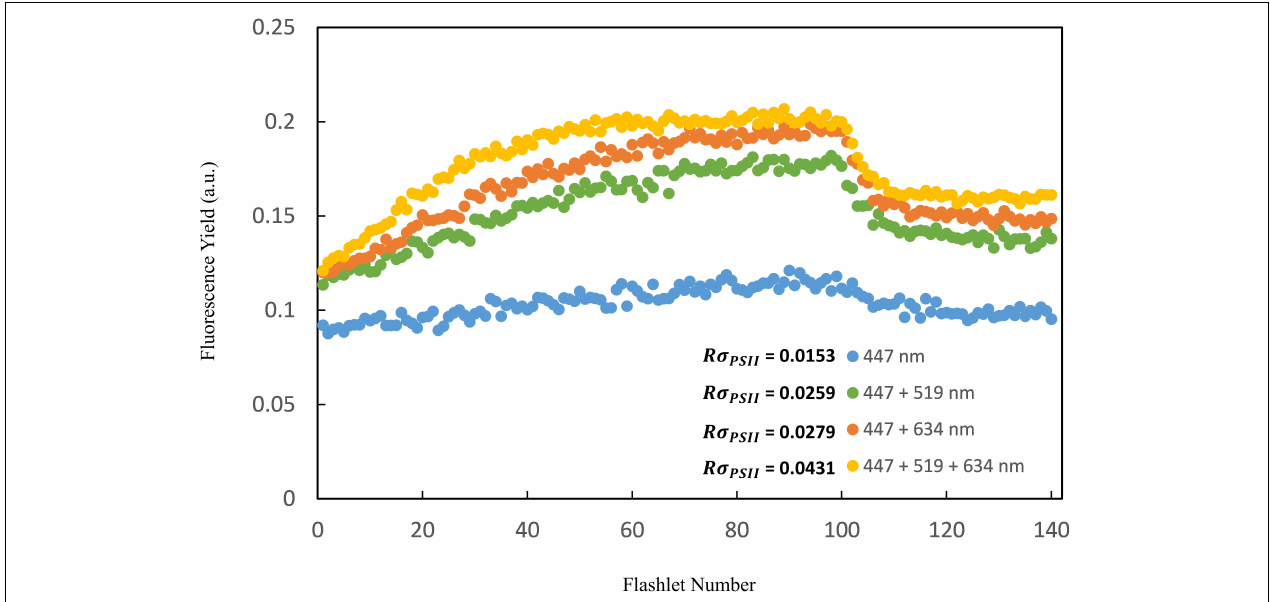
FIGURE 3 | The raw fast repetition rate (FRR) flurometer fluorescence induction kinetic curves of four different lights combinations (blue: 447 nm; blue + green: 447 + 519 nm; blue + orange: 447 + 634 nm and blue + green + orange: 447 + 519 + 634 nm) for the Trichodesmium study (using K14 as an example). Results showed that the FRRf measurement protocol consisting of three excitation wavelengths combined generated the highest quality data ( R σ PSII > 0.03).